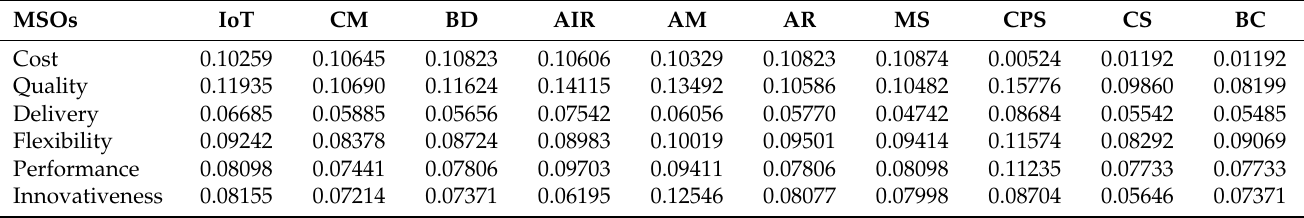
Table 12. The weighted normalized average fuzzy decision